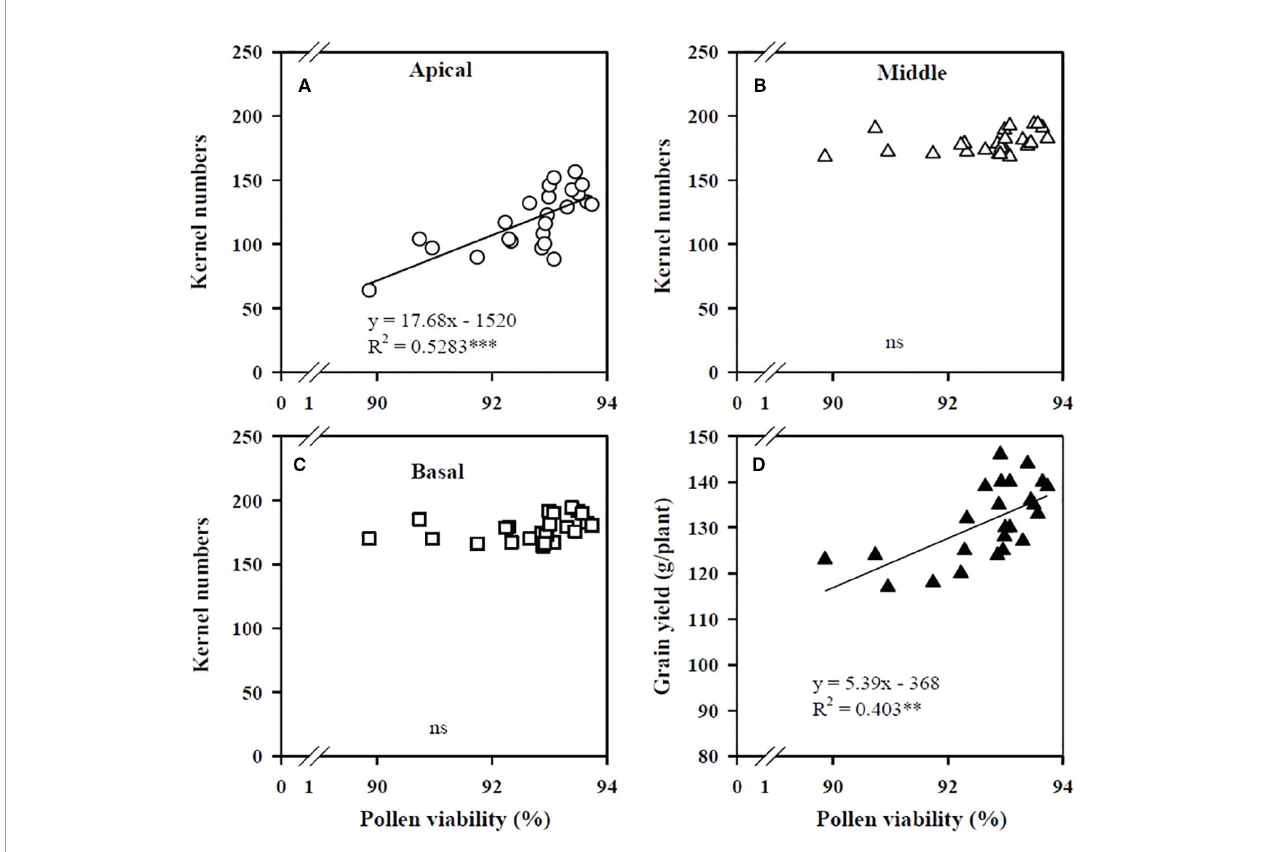
FIGURE 2 | Correlations of the kernel numbers of the apical (A) , middle (B) , and basal (C) sections of maize spikes and maize grain yield (D) with pollen viability at the tasseling (VT) stage in the fi eld. The percentage of pollen viability was determined as the ratio of the number of energetic pollens to the total pollens number. *** P < 0.001 and ** P < 0.01. ns, not signi fi